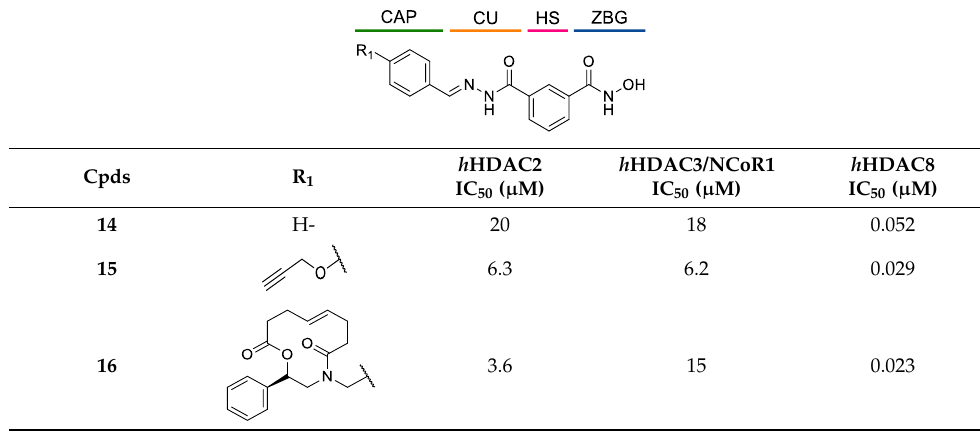
Table 1. General structure and IC 50 values of 14 , 15 , and 16 [139].